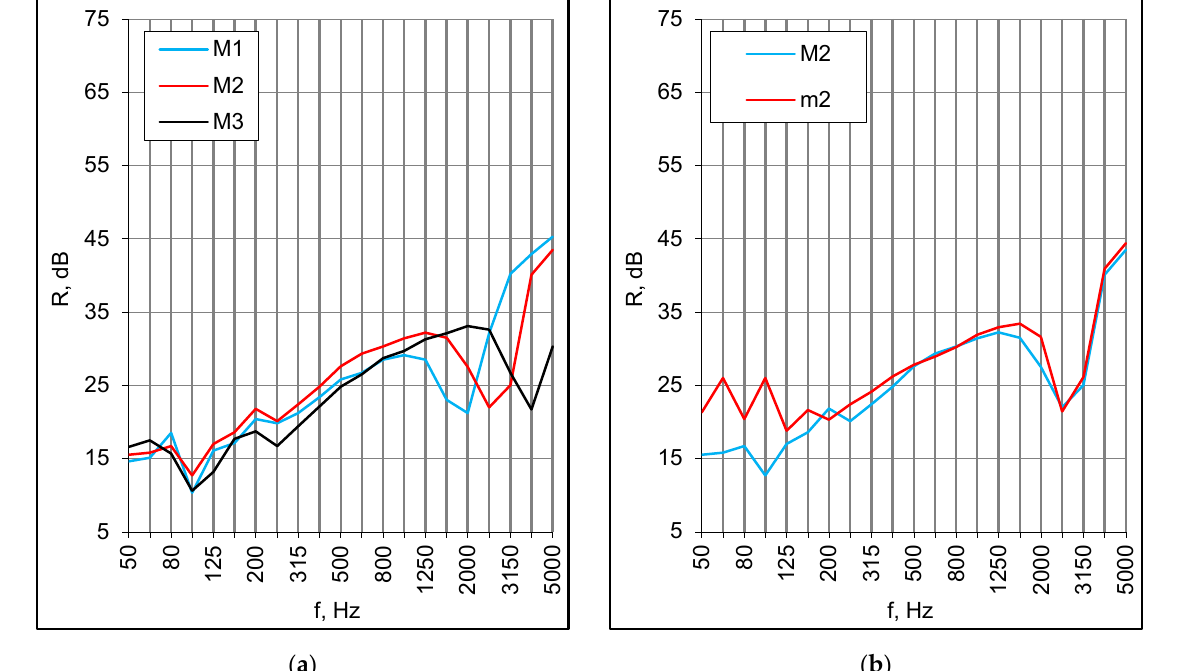
Figure 6. Sound reduction index of standalone panels, ( a ) full-scale models; ( b ) comparison of small elements and full-scale models.